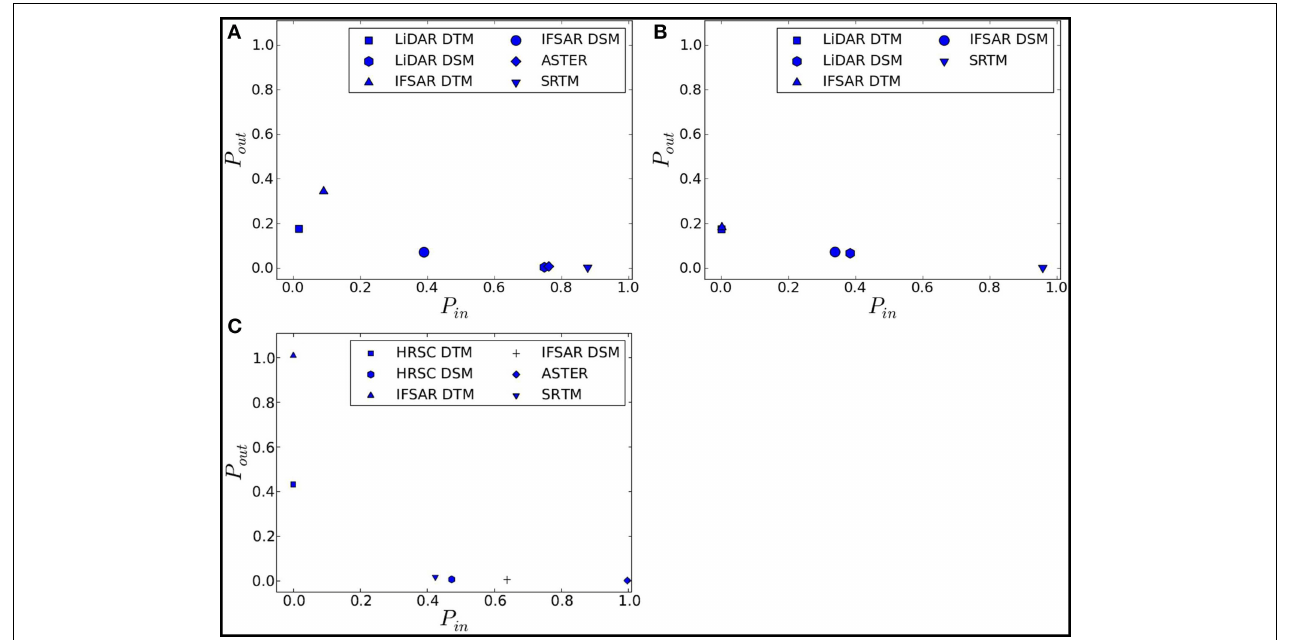
FIGURE 6 | P in and P out values for (A) Maumere, ANUGA model; (B) Maumere, TsunAWI model; and (C) Padang, ANUGA model, calculated against the benchmark models. Comparison models use Manning’s n 0 . 025 while benchmark models have onshore n = 0.06 (Maumere) and 0.08 =